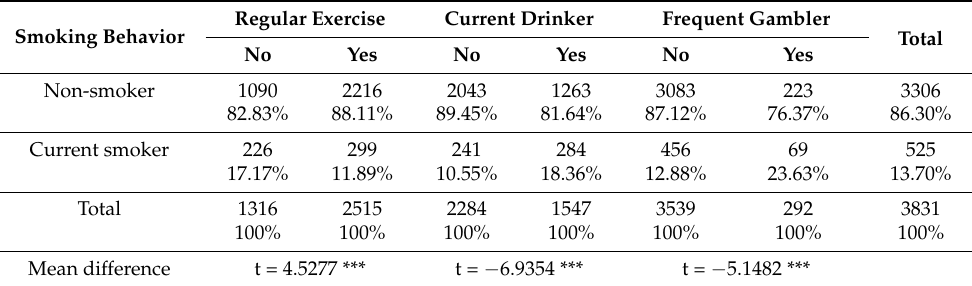
Table 5. Distribution of smoking behavior by risky